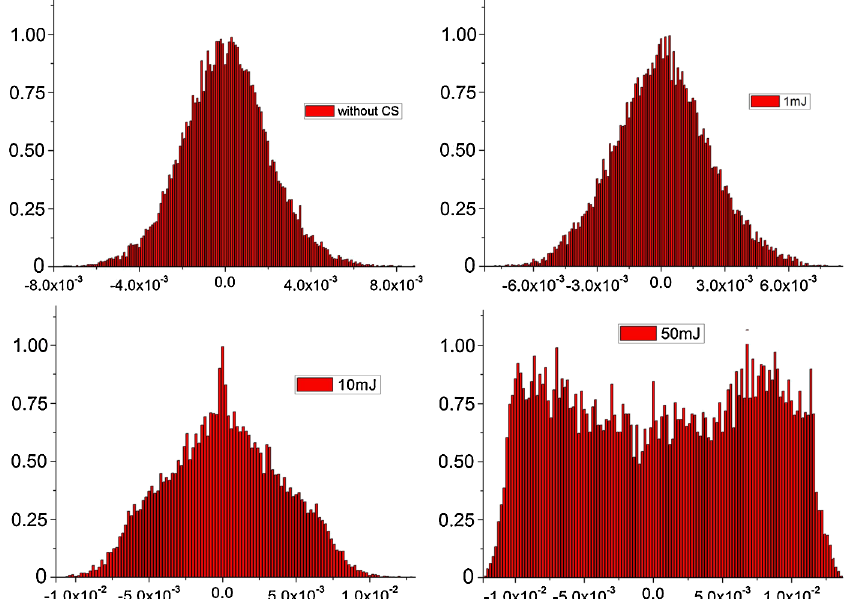
FIG. 5. (Color) The normalized longitudinal momentum distributions of the electron beam at 200 000 turns of the storage period. The stored laser energy is 0, 1, 10, and 50